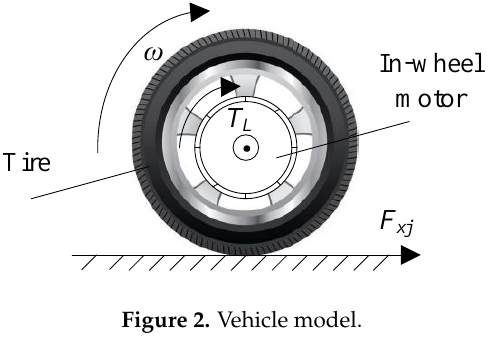
Figure 2. Vehicle model.